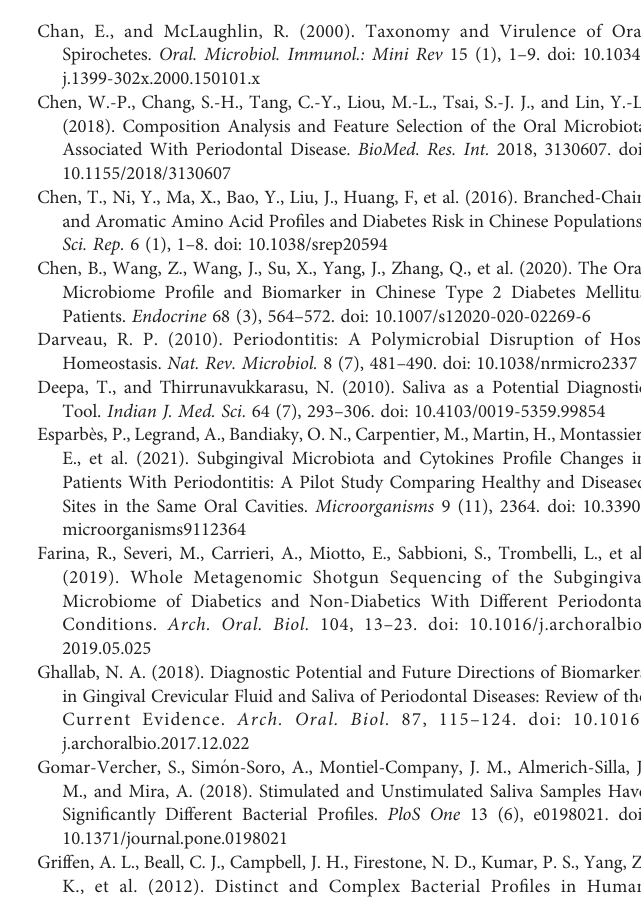
Supplementary Figure S3 | T test analysis of species differences at the species level between groups. (A) TC and H groups. (B) CP and H groups. (C) TC and CP groups. The left picture shows the difference in species abundance between groups, and each bar in the fi gure represents the mean value of species with signi fi cant differences in abundance between groups in each group. Supplementary Figure S4 | PICRUSt predictions of the functional composition of the saliva microbiome. (A) KEGG pathway at level 1 between the TC and the H groups; (B) KEGG pathway at level 1 between the CP and the H groups; (C) KEGG pathway at level 2 between the TC and the H groups; (D) KEGG pathway at level 2 between the CP and the H groups. The left picture shows the difference in species abundance between groups, and each bar in the fi gure represents the mean value of species with signi fi cant differences in abundance between groups in each group. Supplementary Figure S5 | PICRUSt predictions of the functional composition of saliva microbiome at level 3 between TC and H group. The left picture shows the difference in species abundance between groups, and each bar in the fi gure represents the mean value of species with signi fi cant differences in abundance between groups in each group. Supplementary Figure S6 | PICRUSt predictions of the functional composition of saliva microbiome at level 3 between CP and H group. The left picture shows the difference in species abundance between groups, and each bar in the fi gure represents the mean value of species with signi fi cant differences in abundance between groups in each